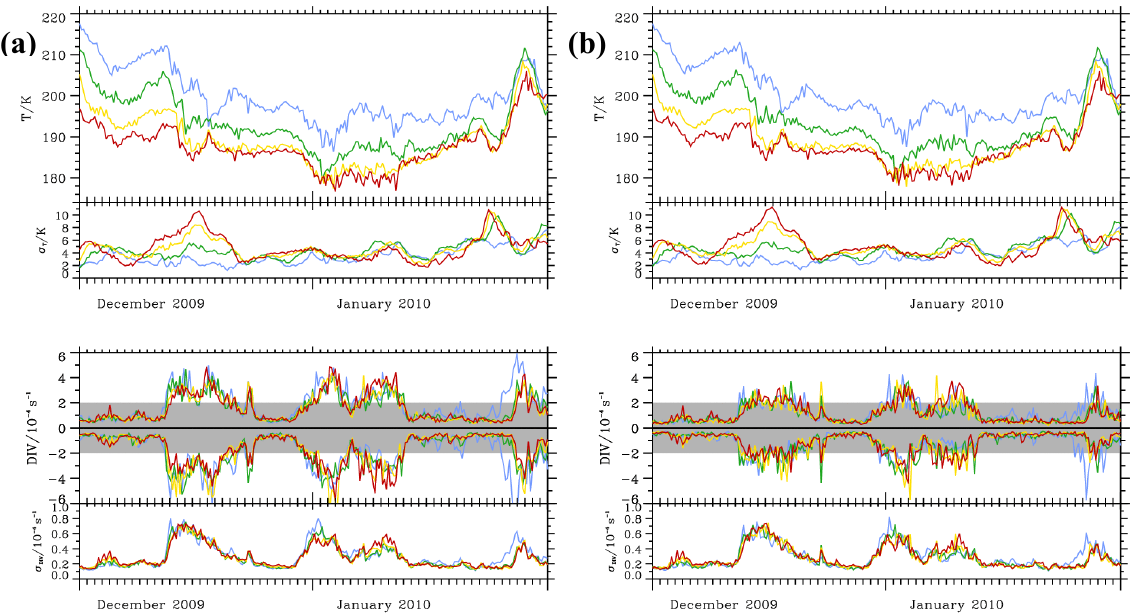
Fig. 17. Stratospheric gravity waves: top panels: T MIN and standard deviations σ T (K) above Greenland (60 to 85 ◦ N, 60 to 20 ◦ W) at isentropic surfaces (colour coded: blue: 410K, green: 470K, yellow: 530K, red: 590K) for December 2009 and January 2010. Bottom panels: same as above but for minimum and maximum horizontal divergence DIV MIN and DIV MAX and the standard deviations σ DIV (s − 1 ) . The standard deviations σ T and σ DIV are calculated spatially in the analysed domain. The gray shading encloses DIV values below the threshold used for identifying stratospheric gravity waves. ECMWF operational analyses interpolated at a regular 0 . 25 × 0 . 25 (a) and 2 . 50 × 2 . 50 ◦ (b) latitude/longitude grid, respectively.